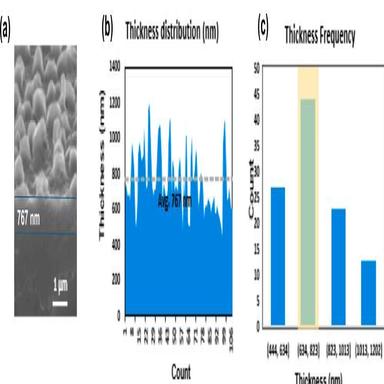
AlH3 thin film surface morphology: (a) SEM tilted view at the edge, highlighting the topography and providing a perspective on the texture and uniformity of the film; (b) thickness distribution illustrating the spatial variation in thickness; and (c) thickness frequency histogram showing the distribution results of thickness measurements.